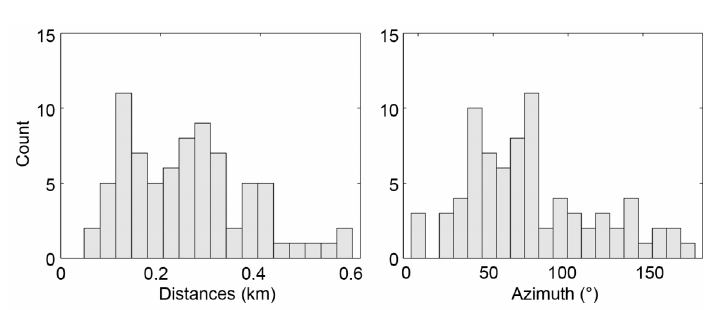
Fig. 2. Histograms of station spacing ( left ) and relative orientation ( right ) for all the indepedent station pairs of the